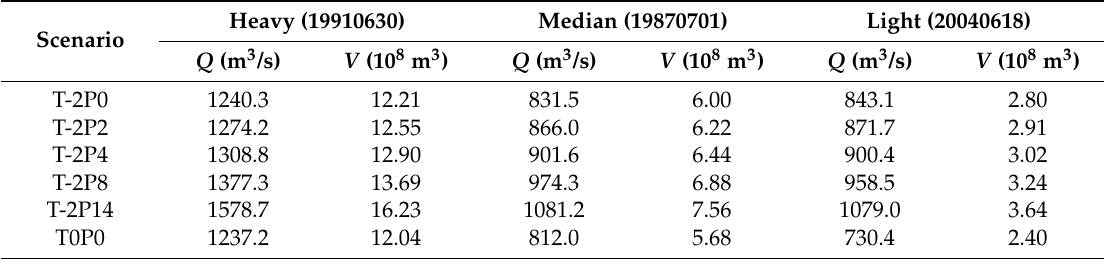
Table 5. The simulated results of floods under 20 climate